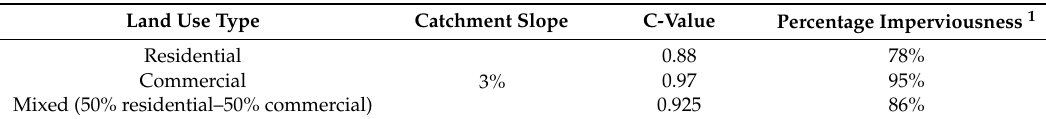
Table A4. Runoff coefficients and percentage imperviousness adopted for the various land uses.